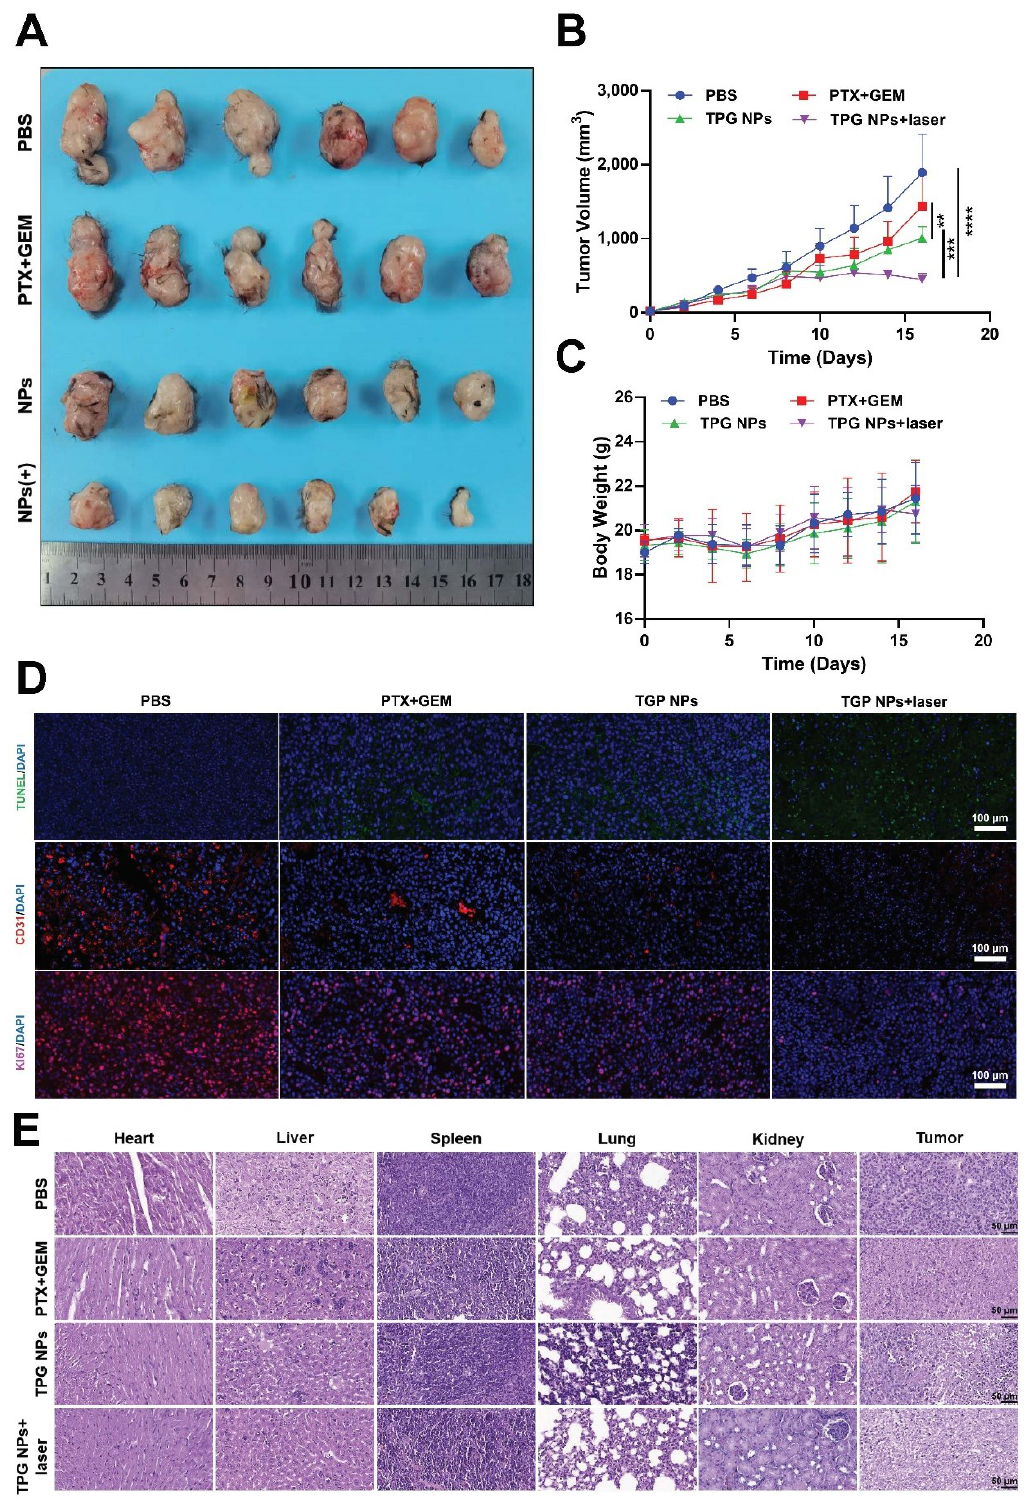
Figure 7. In vivo anti-tumor therapy and biosafety of TPG NPs. Image of tumors ( A ), recorded tumor growth ( B ) and body weight ( C ) of C57BL/6 mice treated with different formulations for 9 days. Date was expressed as the mean ±SEM ( n = 6). ** p < 0.01. *** p < 0.001. **** p < 0.0001. ( D ) Fluorescence microscopy images of sliced tumor tissues stained with Tunel (green), CD31 (red), Ki67 (purple) and DAPI (blue) (scale bar = 100 μm). ( E ) Representative H&E-stained tumor slice images of mice after various treatment (scale bar = 5 0 μ m).